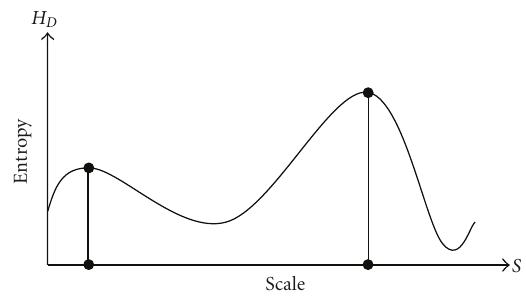
Figure 1: Local maxima of function H D in the scale space S